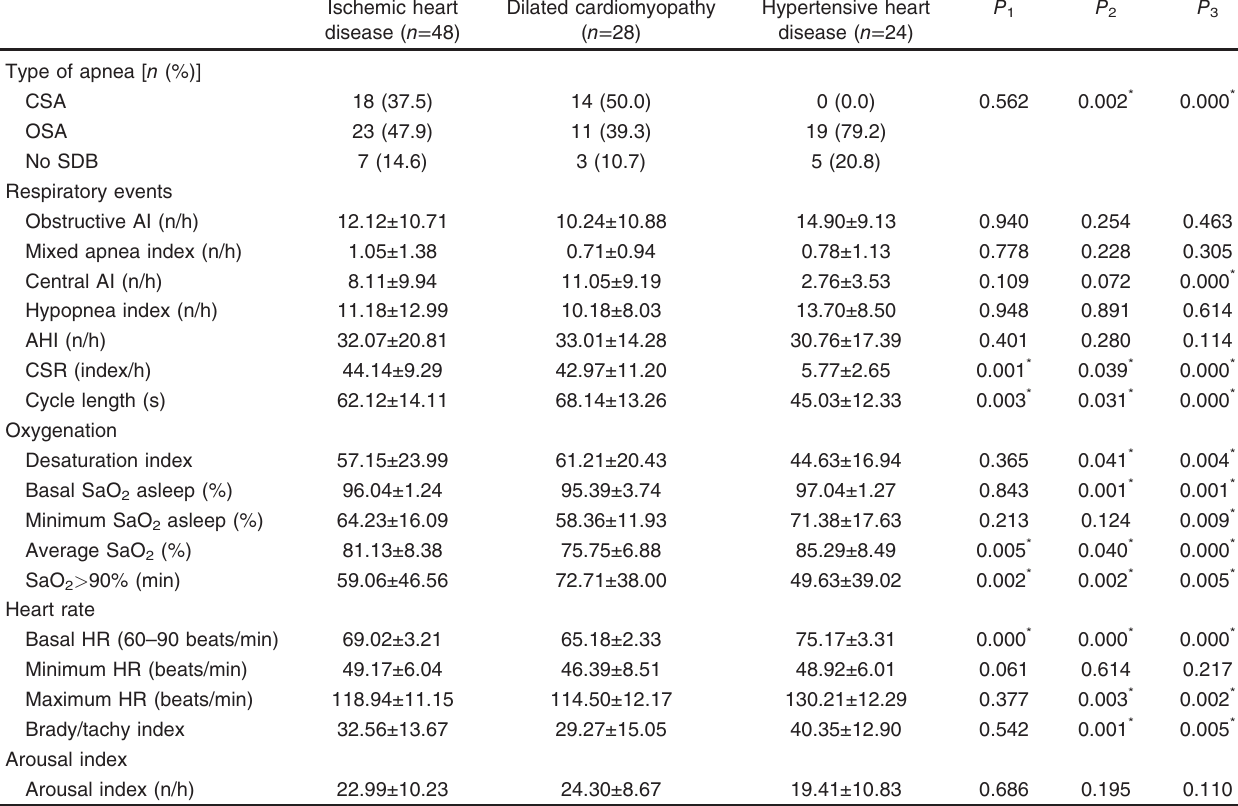
Table 4 Baseline polysomnographic data in different groups of heart failure